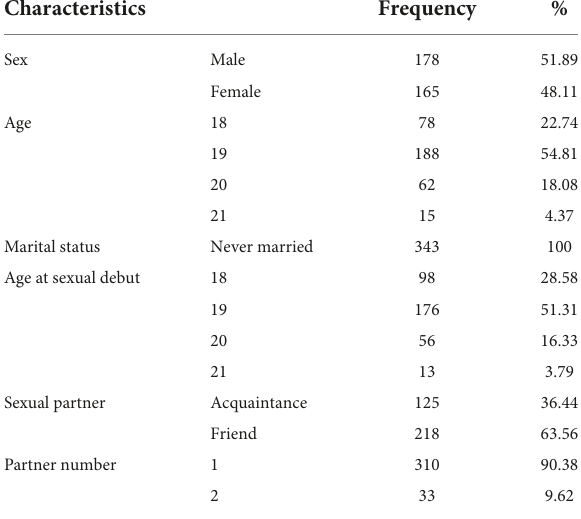
TABLE 2 Level of self-esteem and exposure to peer pressure among students having an experience of premarital sex. Variables Observed mean